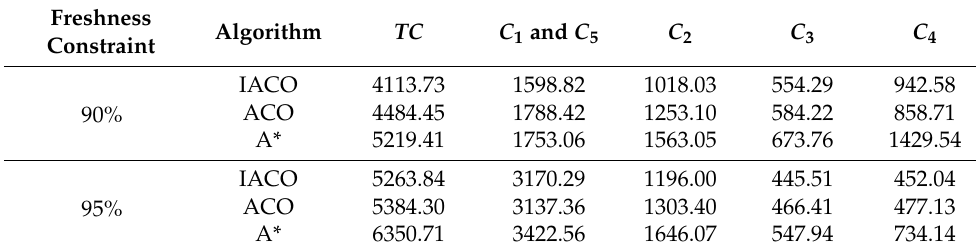
Table 4. Comparison of different algorithms with the minimum total